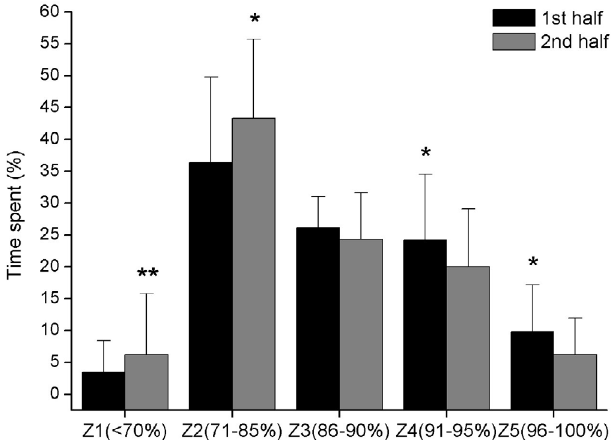
Figure 3. Time spent in five player internal load zones. Player internal load expressed as a percentage of maximal heart rate during official match-plays in youth soccer players (n=21). Data are mean ± SD. *, **, denotes significant difference vs. other half at p <.05 and p <.01 levels, respectively.